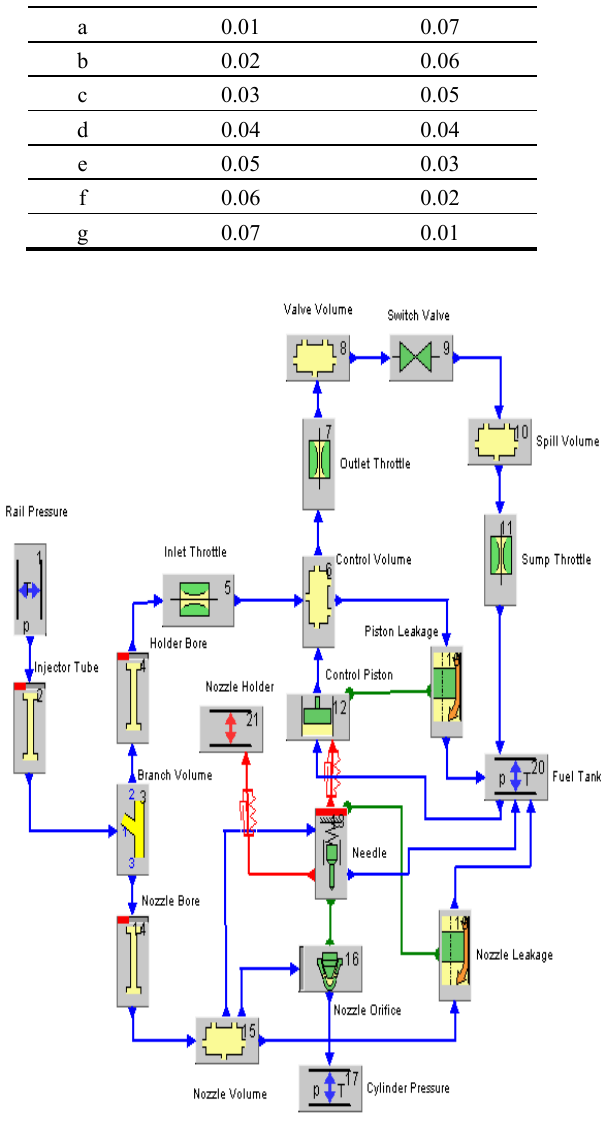
Fig.3 the simulation model of injector